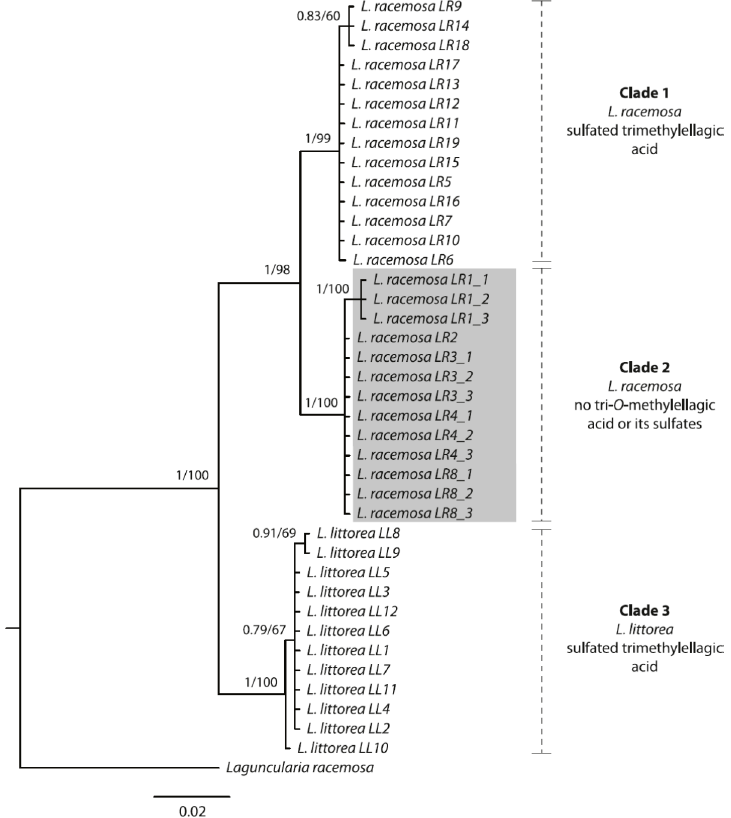
Figure 4. Bayesian majority-rule consensus tree based on the ITS rDNA region of Lumnitzera littorea and L. racemosa samples collected from various locations in Indonesia. Numbers above branches show Bayesian posterior probability values and corresponding bootstrap support values from the maximum likelihood analysis. Grey: highly supported clade, forming a different chemotype.